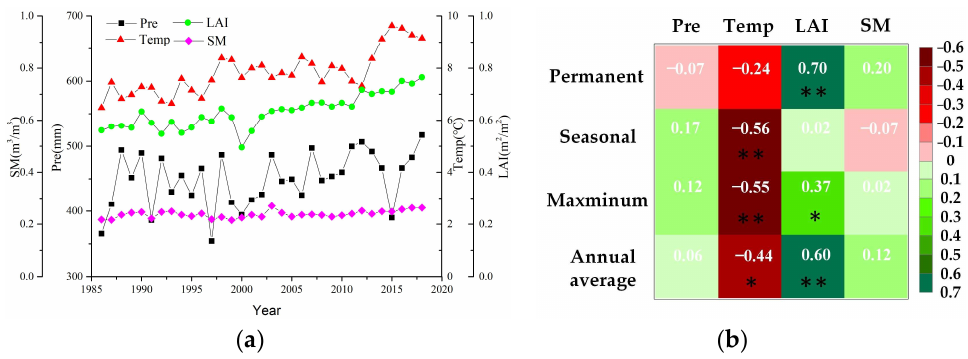
Figure 15. ( a ) Interannual variations in the environmental factors, and ( b ) the correlation coefficients between the environmental factors and the different types of water bodies in the entire YRB. ** denotes p < 0.01; * denotes p < 0.05.